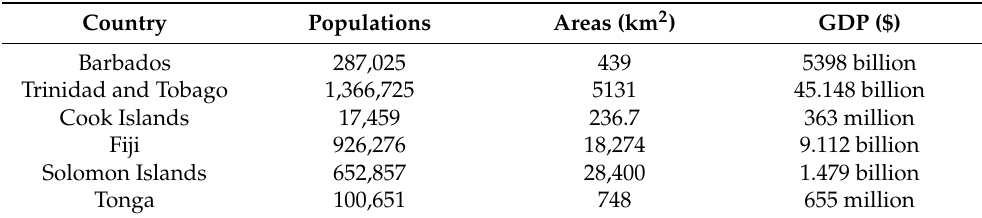
Figure 2. Schematic distribution of the six sampled islands. Table 2. EM-DATA